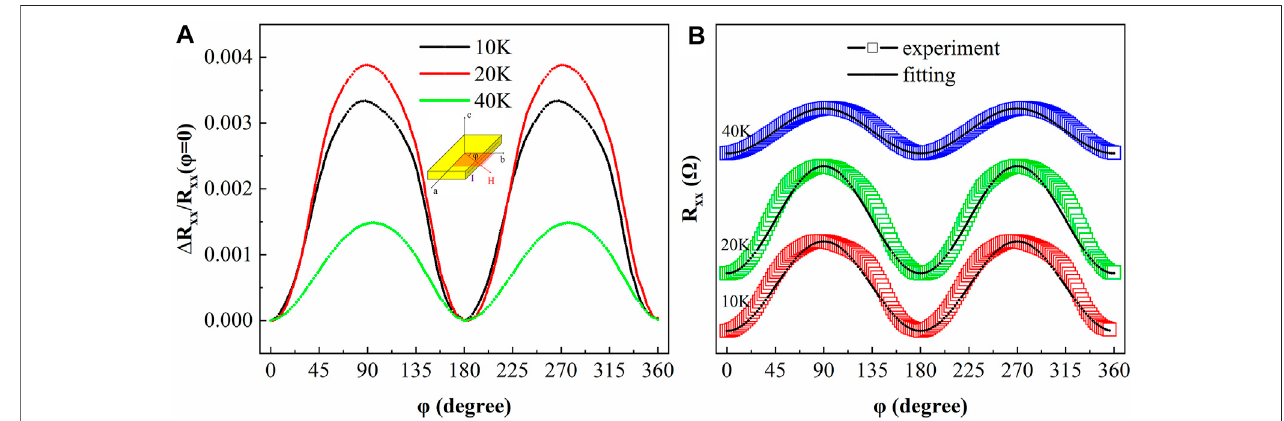
FIGURE 4 | (A) Measured angle-dependent magnetoresistance at 10, 20, and 40 K with the fi xed 9T magnetic fi eld rotates in the ab-plane, and the inset shows a schematic of the measurement con fi guration. (B) Fitting results of in-plane anisotropic magnetoresistance.